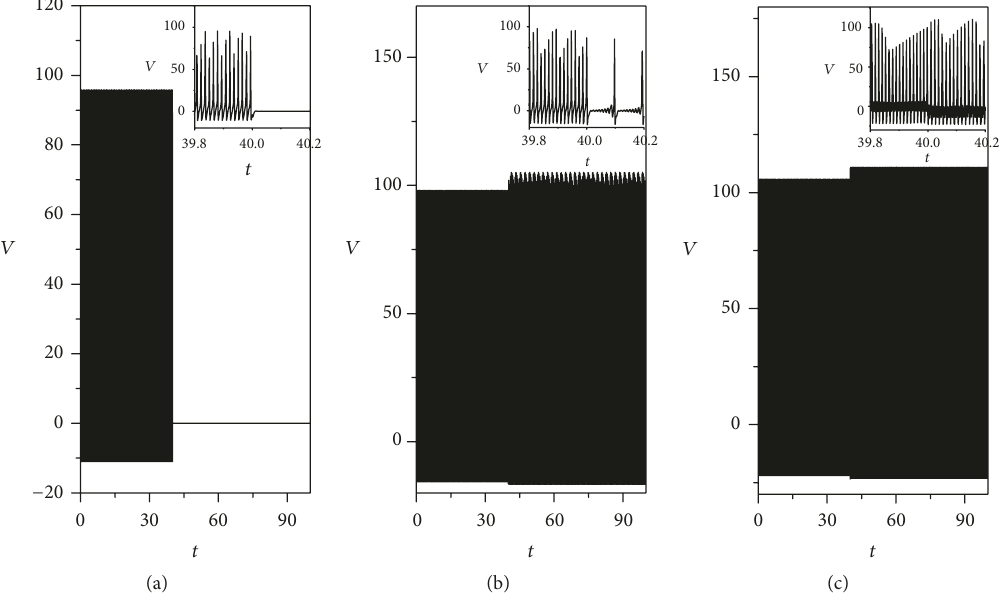
Figure 2: Sampled time series for membrane potential of neuron coupled by astrocypte when autapse driving is considered at 𝜏 = 2 , for (a) 𝑔 = −0.1 , (b) 𝑔 = −0.5 , and (c) 𝑔 = −1.0 . The parameter is set as 𝑟 𝑒 𝑒 𝑒 current regulates the neuron by 𝐼 ext = 10.0 𝜇 mol/L ⋅ cm 2 at 𝑡 < 40